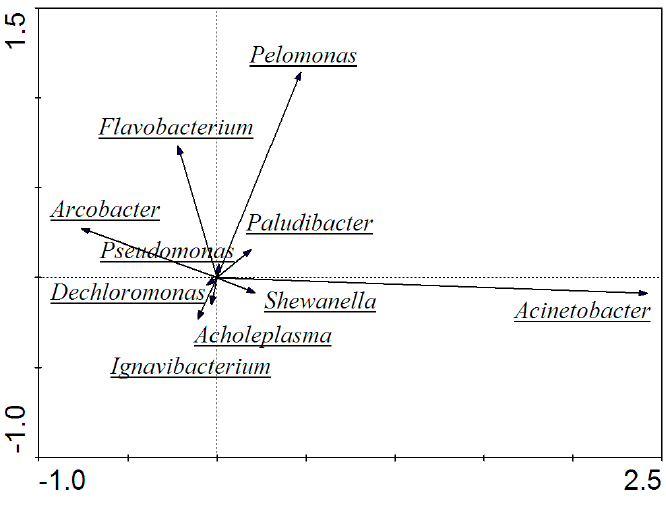
Figure 8. Principal component analysis (PCA) at the genus level.